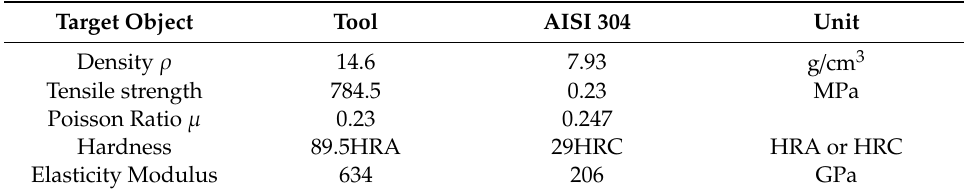
Table 3. Chemical composition of AISI 304 (wt %).